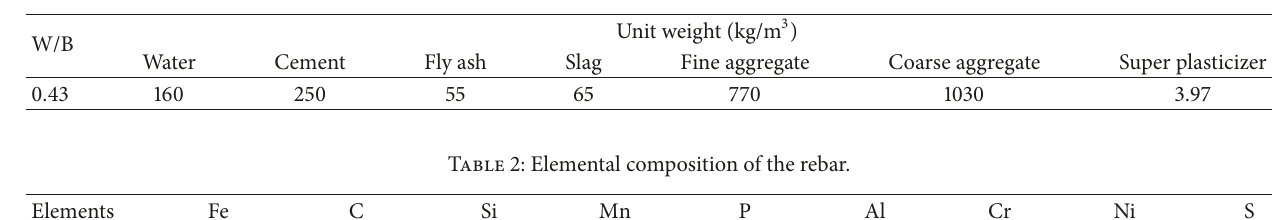
Table 1: Mixture proportions of prism concrete.